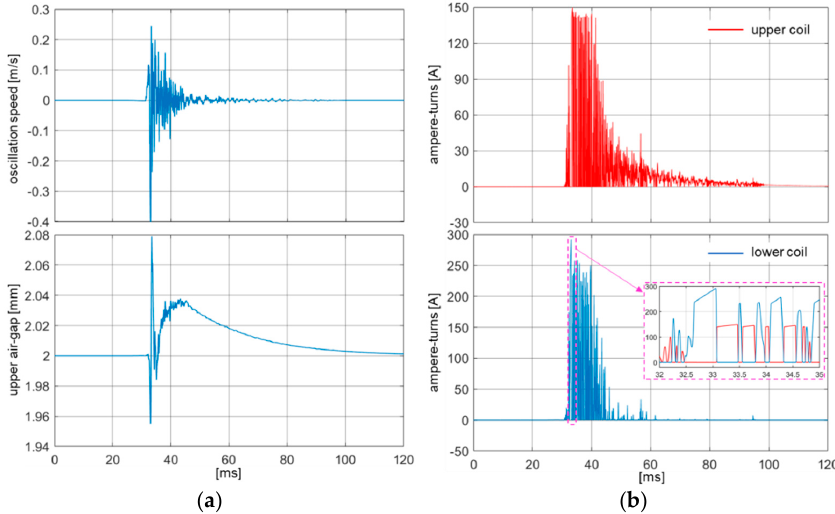
Figure 17. Simulation results of a seismic event; ( a ) oscillation speed and upper air-gap variation; ( b ) upper and lower coil ampere-turns (dotted box: zoomed interval on ampere-turn variation).